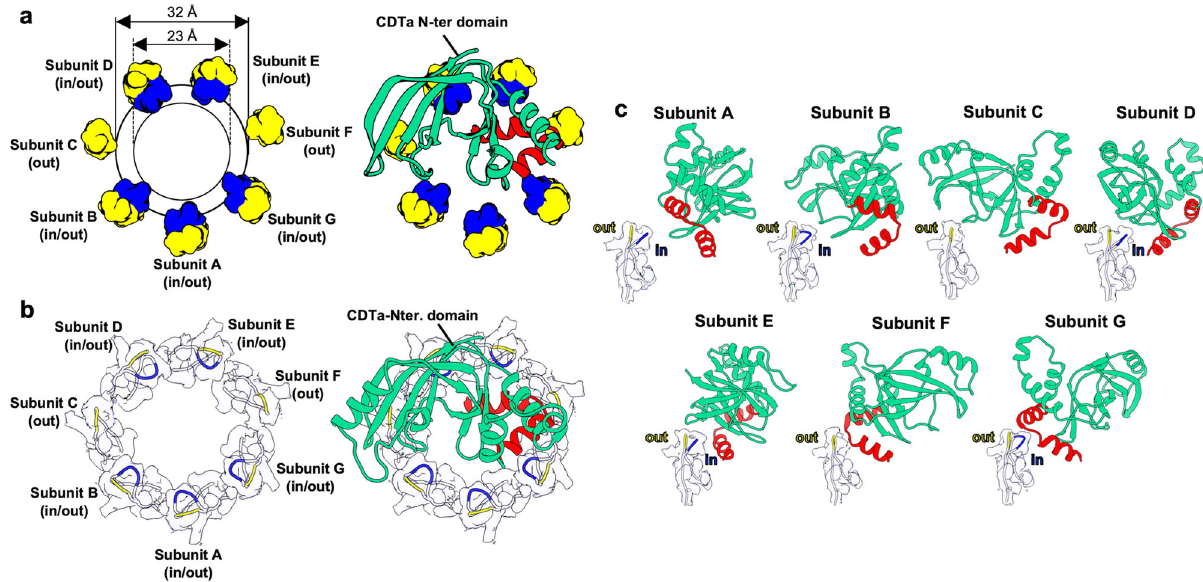
Fig. 4 | NSS-loop conformations. a Concentric circles of NSS-loops. Conforma- tions in the CDTa-bound state are shown without (left) or with (right) the CDTa N-terminaldomain. ‘ in ’ loop conformations are shown in blue, ‘ out ’ conformations